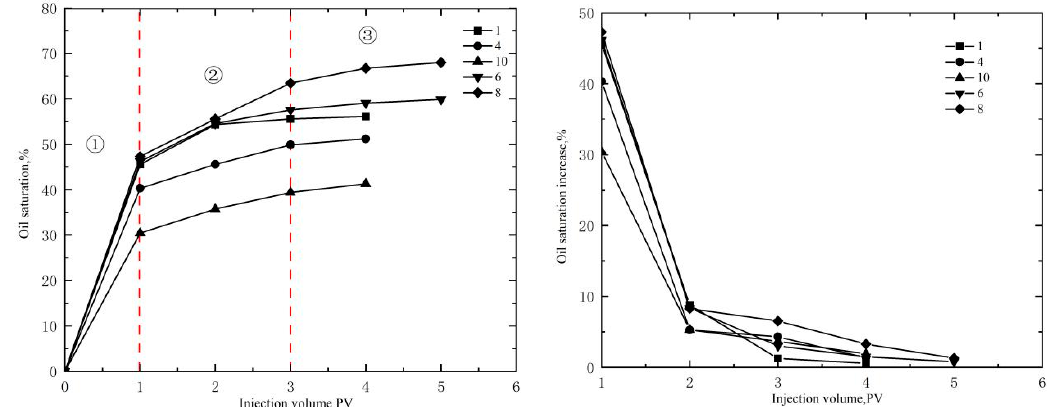
Figure 5. Relation between charging volume and oil saturation, increment in oil